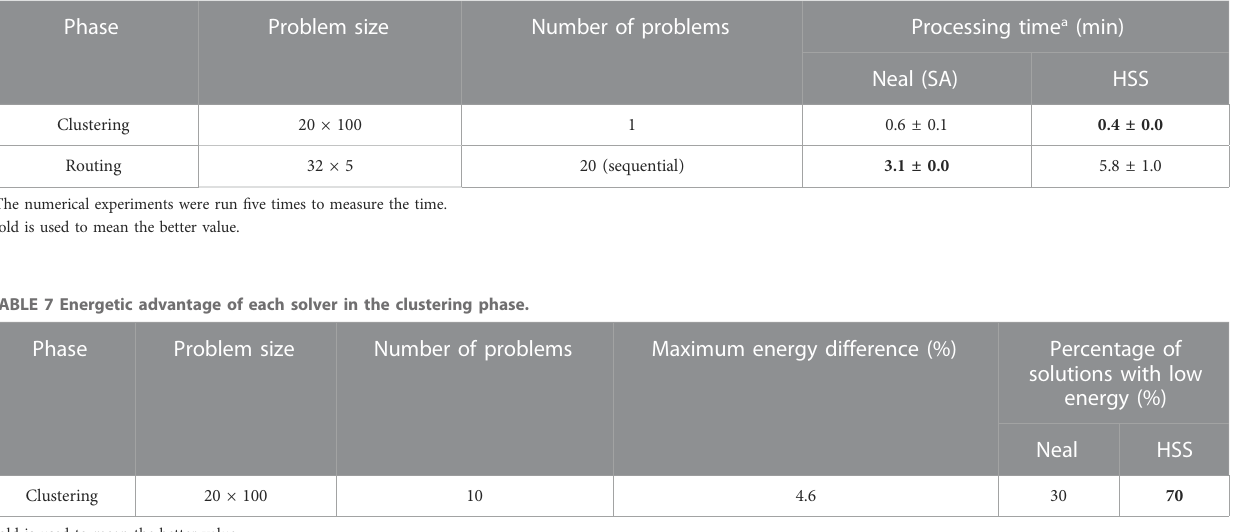
Table 8. The application of the results of fi ve numerical experiments,